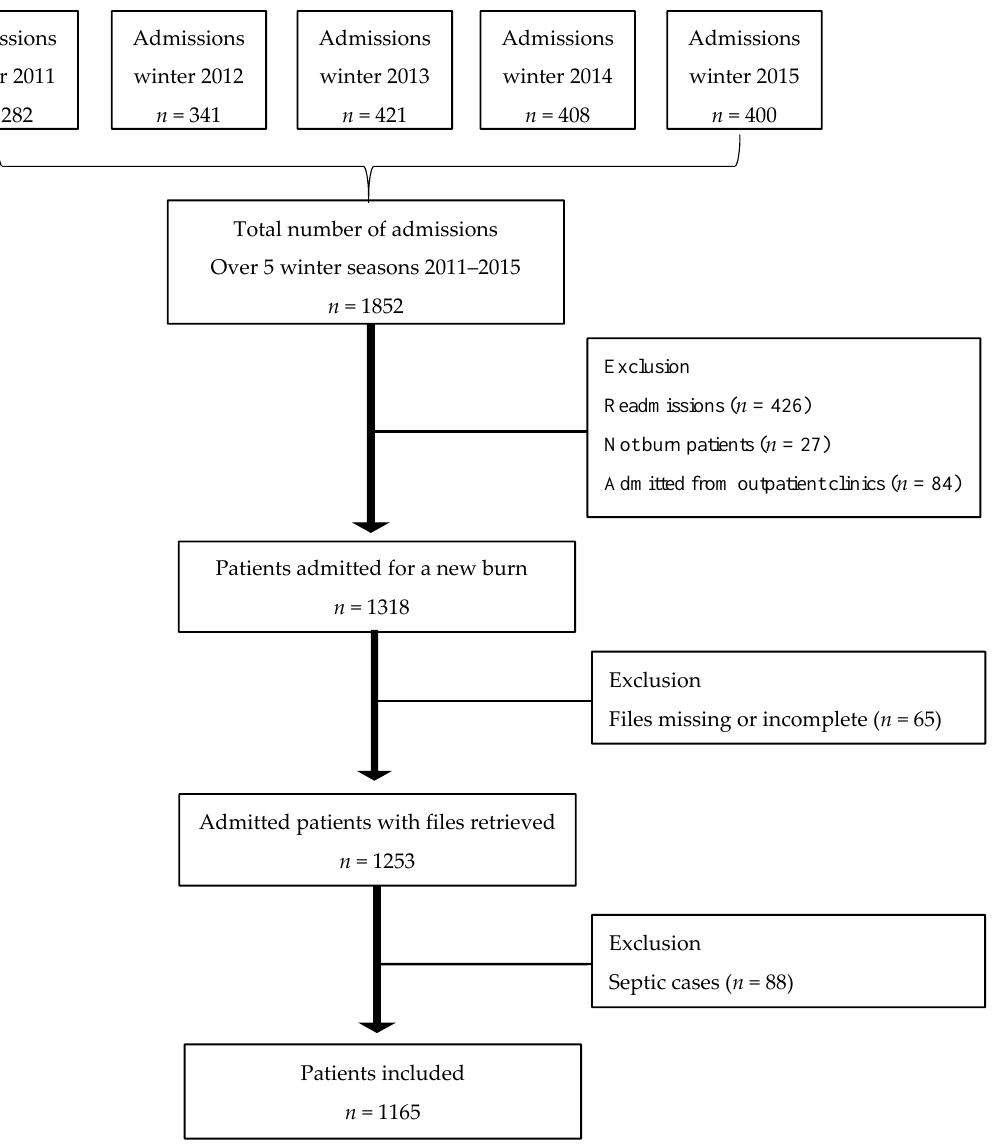
Figure 1. Flow chart of the inclusion/exclusion process used for data collection.